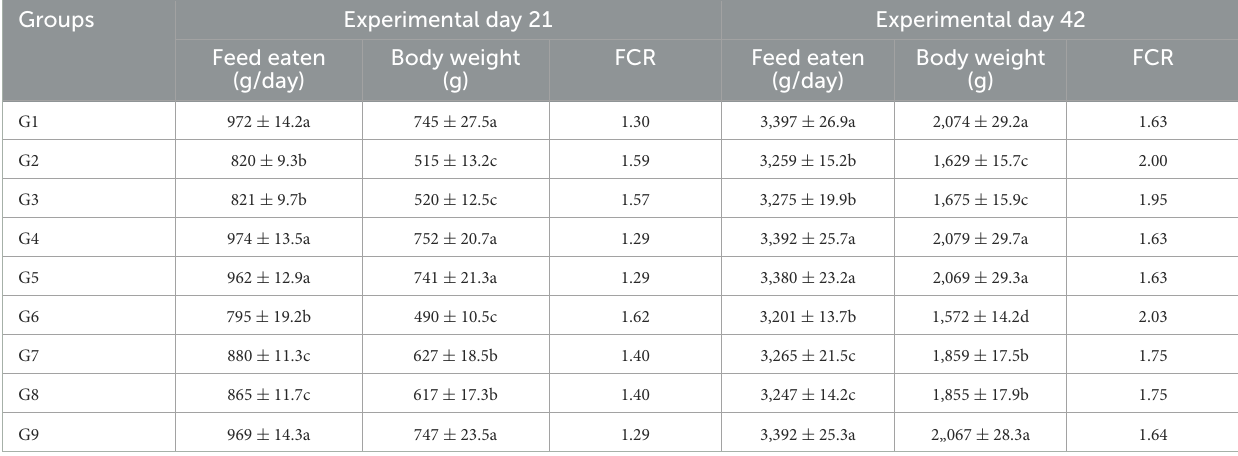
TABLE 1 Physical parameters like feed intake, body weight, and feed conversion ratio on experimental days 21 and 42 in broiler chicks fed chromium, arsenic, bentonite, and vitamin E singly or in blends. Groups